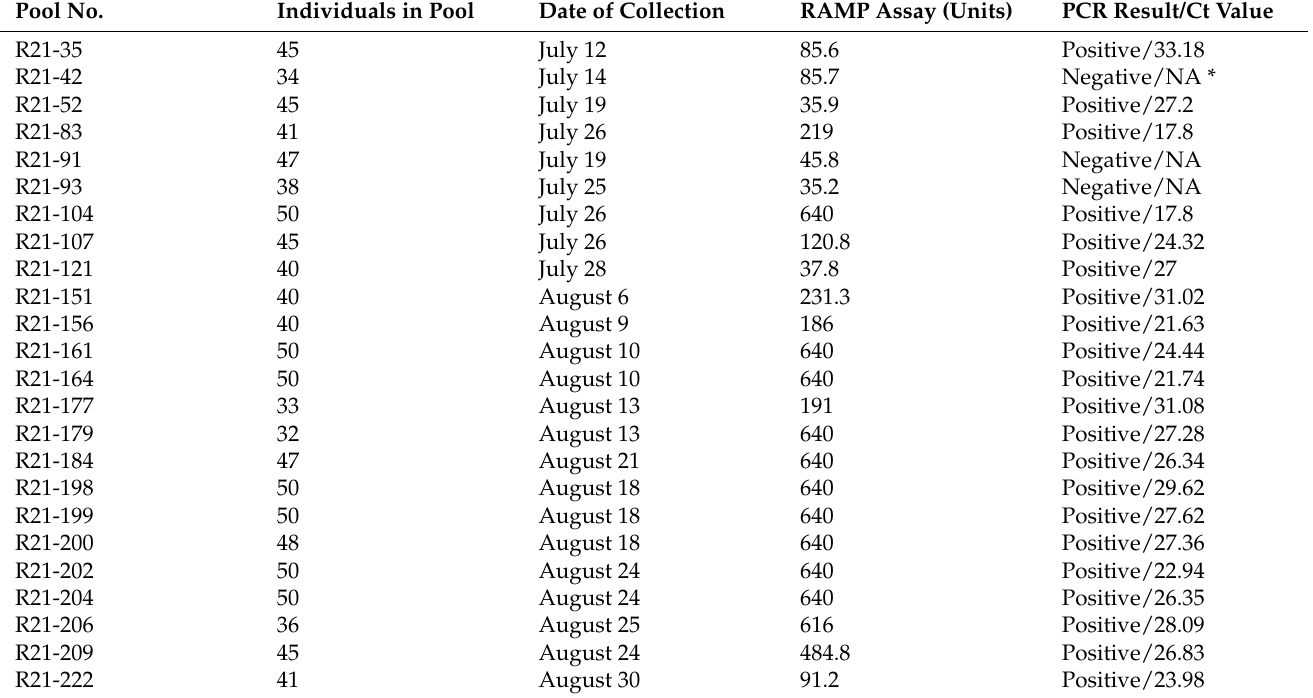
Table 1. Real-time RT-PCR results for Culex pipiens female pools testing positive for WNV in RAMP